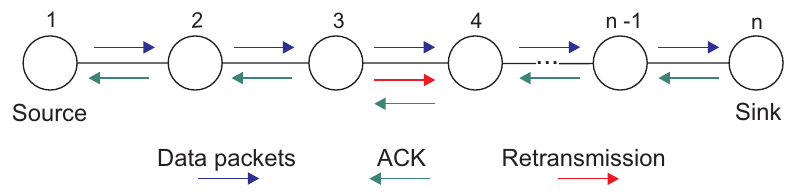
Figure 1. ACK messages in hop-by-hop packet